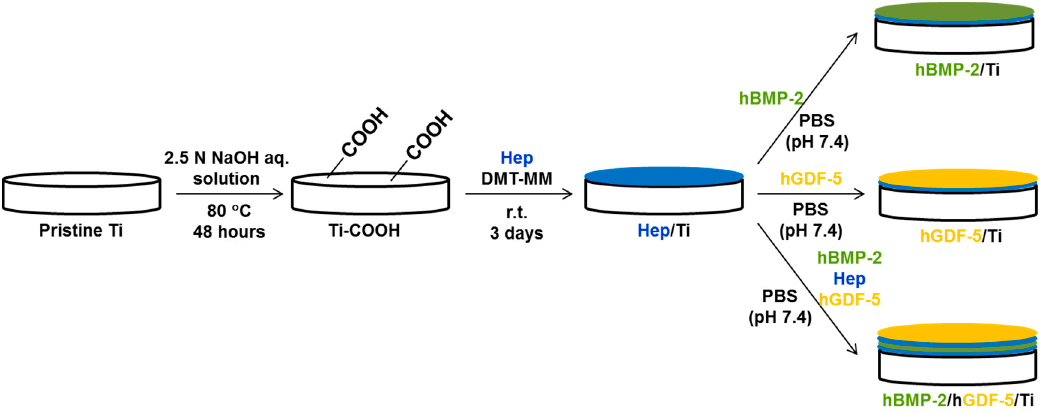
Figure 10. Schematic for the preparation of pristine Ti; BMP-2/Ti; GDF-5/Ti; and BMP-2/GDF-5/Ti discs (diameter: 8 mm; height: 1 mm) and screws ( φ 3.5 mm × 8.5 mm). The two types of Ti samples were surface-modified by the same process.